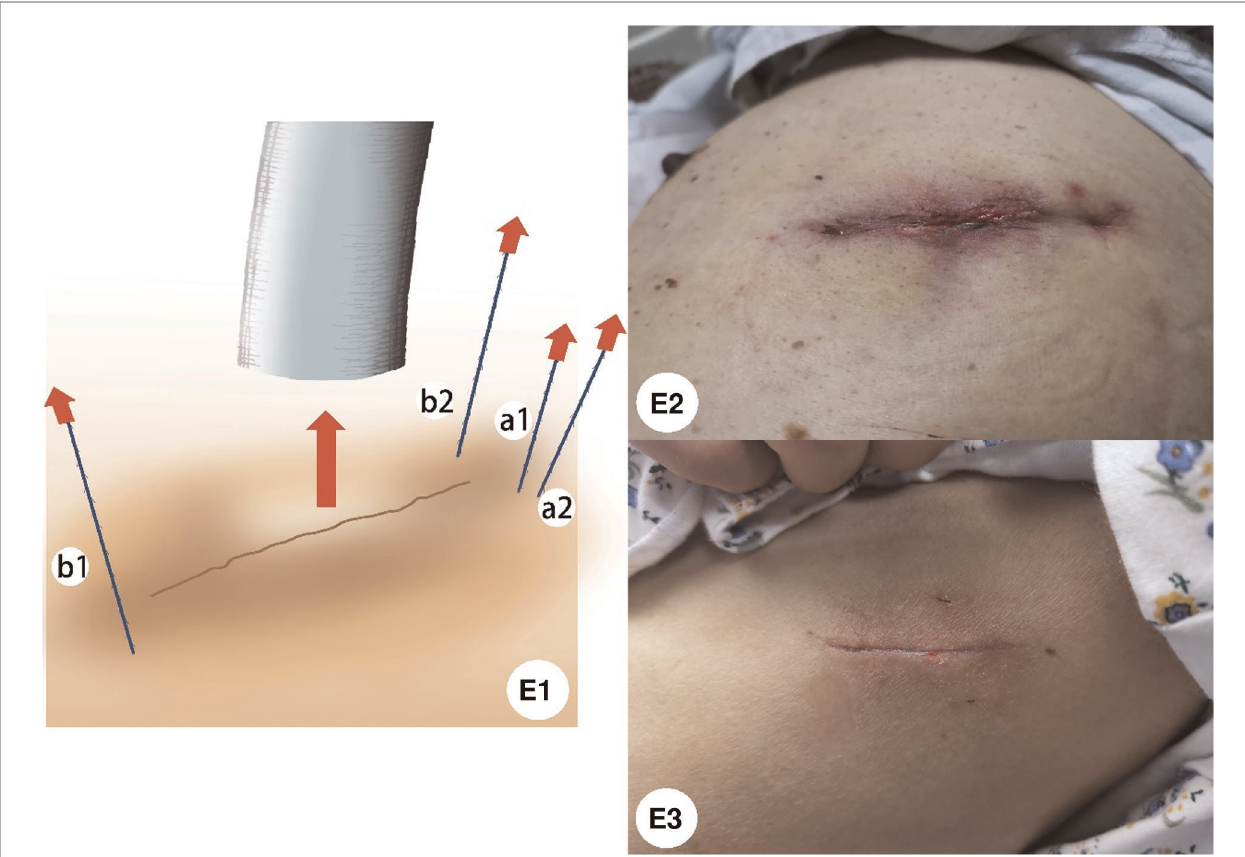
FIGURE 2 | ( E1 ) Before the chest tube is removed, loosen the thread twined around the tube and pull it out of the tissue. When the chest tube was removed, the incision was pressed by gauze swiftly, and then pull the rest of the knotless stitches were one by one to tighten the suture, the wound sealed like closing a zipper. ( E2 ) Appearance of the incision after the chest tube is removed. ( E3 ) One month after the chest tube was removed, the wound of uniportal VATS in the new method group was healed